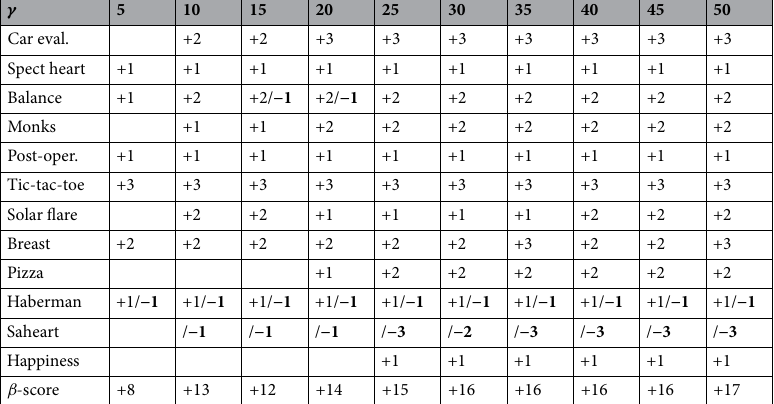
Table 3. Summary of the results, by data set, for different values of the cost ratio γ = boxes indicate for how many classifiers, of the possible 3, there is statistical significance in favor of BOSME (positive) or in favor of SMOTE (negative, in bold). For each γ , we take count of the β -score.